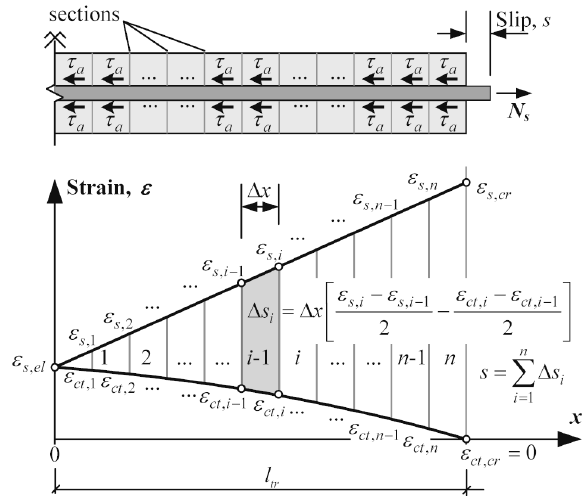
Fig. 5. Strain and bond-slip comparability conditions for